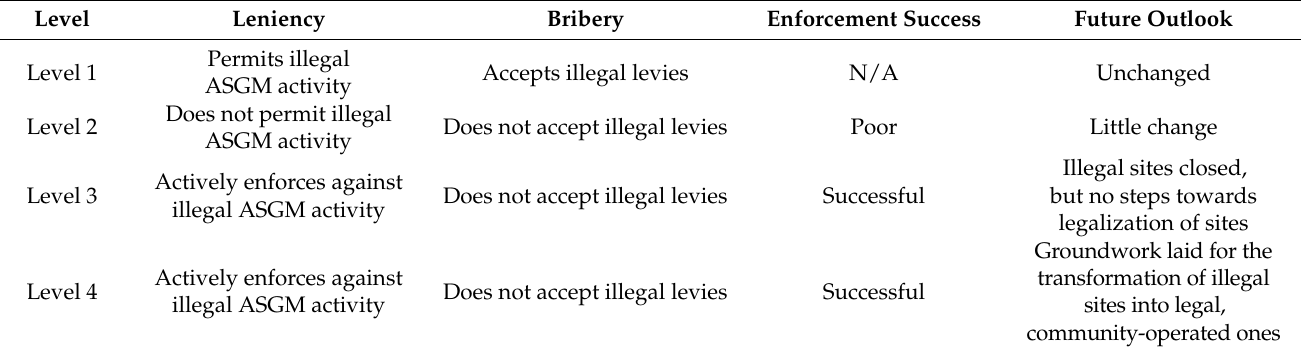
Table 4. Designated levels granted to police regions in their combat against illegal